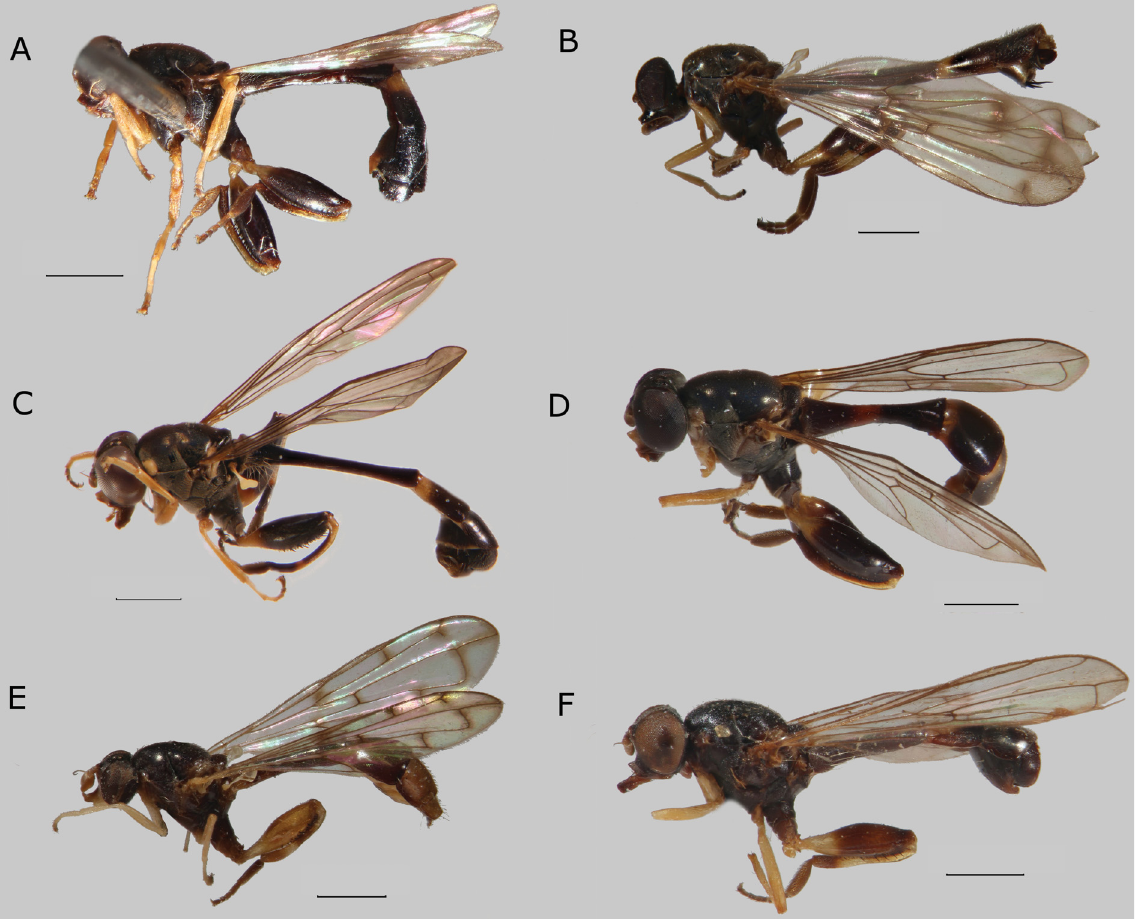
Fig. 23. Habitus, lateral view. A . Sphegina (Asiosphegina) collicola sp. nov ., holotype, ♂ ,